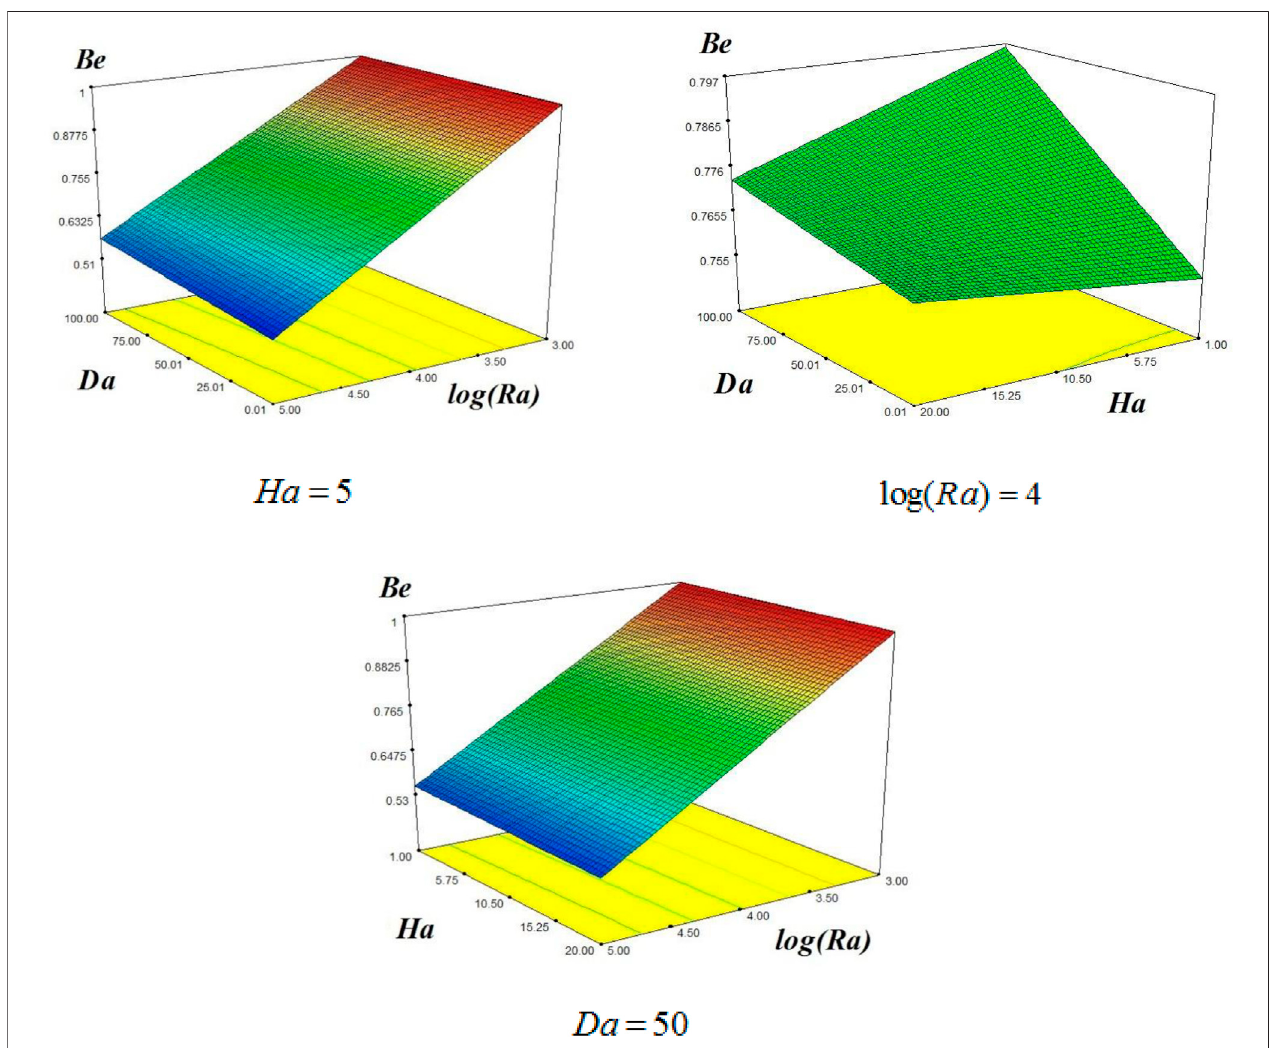
FIGURE 7 | Be values for different